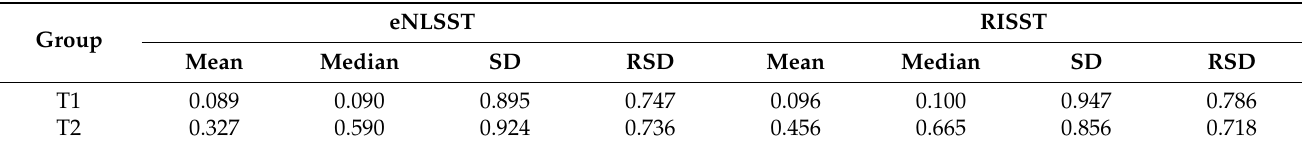
Table 5. Performance of the eNLSST and RISST algorithms with group T1 and T2.